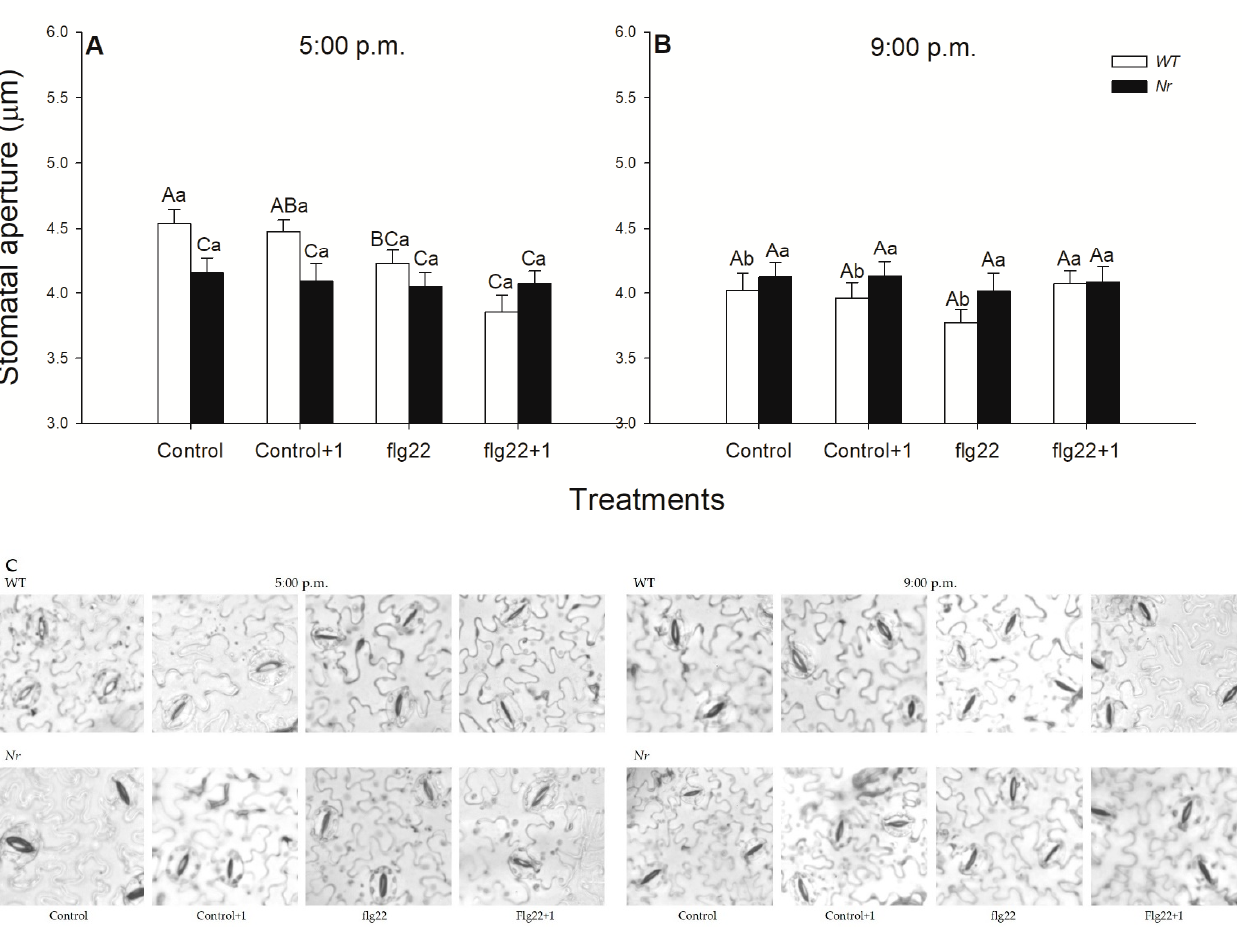
Figure 5. Changes in the size of stomatal apertures on the abaxial epidermal strips of intact wild type (WT; white columns) and ethylene-insensitive Never ripe ( Nr ; black columns) tomato plants treated foliar using a squirrel-hair brush with 5 μ g mL − 1 of flagellin (flg22) in the late afternoon under light (at 5:00 p.m.) ( A ) or at night under darkness (at 9:00 p.m.; ( B ). Measurements were carried out one hour after treatments (at 6:00 p.m. and 10:00 p.m.). Epidermal peels were prepared immediately from the whole leaves from the different leaf levels and genotypes; then, microscopic photos were taken rapidly and the stomatal pore size was determined digitally ( C ). Means ± SE, n = 3. Means were analysed by two-way ANOVA; significant differences among the data were analysed by Duncan’s test. Mean values significantly different at p < 0.05 are indicated by different letters, upper case letters indicate the effects of the treatment at the same time of day and lower case letters indicate the effects of daytime under the same treatment. (Control, treatment with sterile distilled water; Control+1, untreated distal leaf level to the control; flg22, treatment with 5 µ g mL − 1 of flagellin dissolved in sterile distilled water; flg22+1, untreated distal leaf level to the flg22-treated